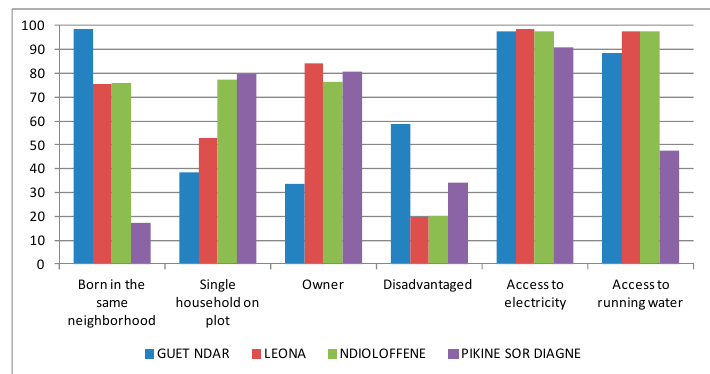
Figure 2. Main characteristics of the surveyed households.